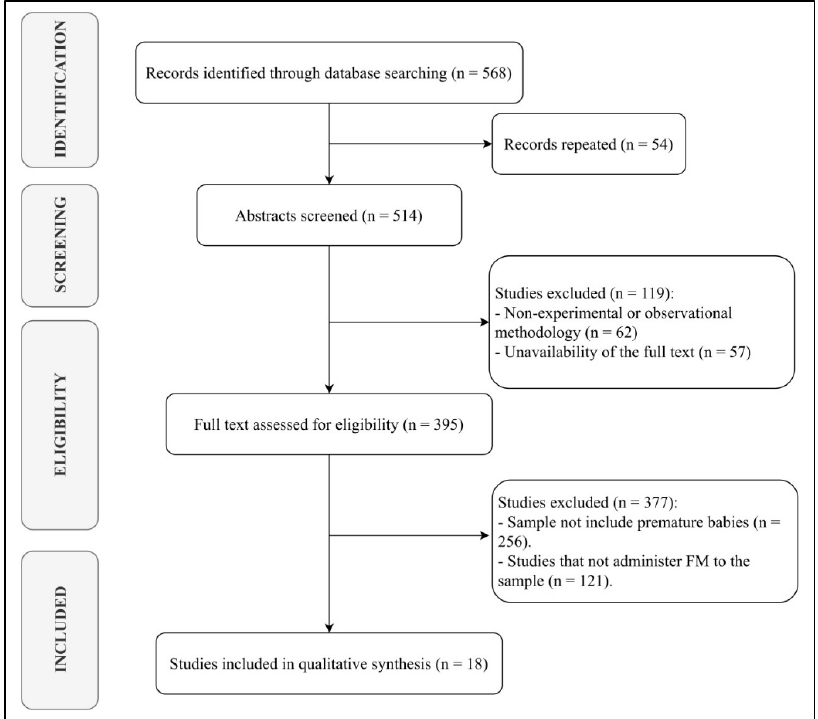
Figure 1. PRISMA flow diagram.